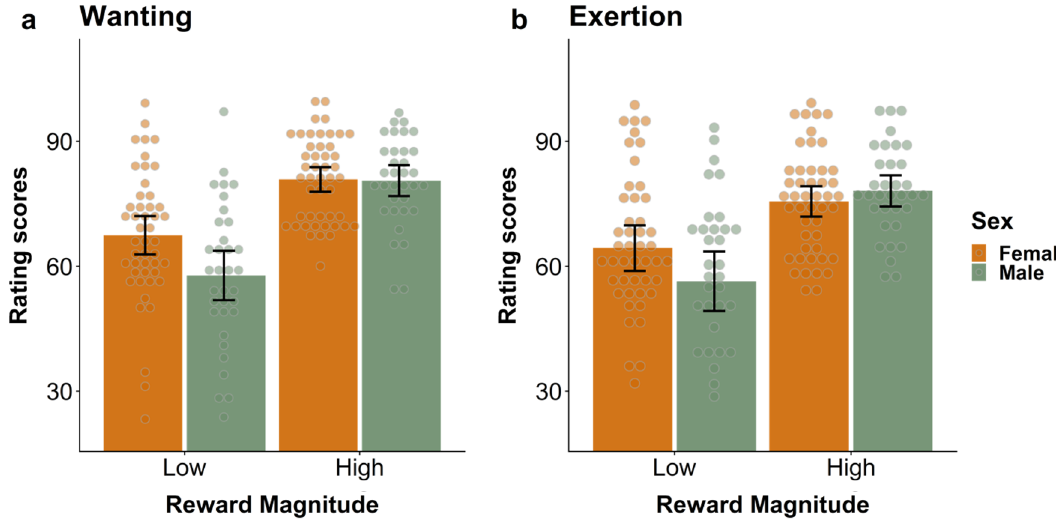
Figure 2. Women and men differed in subjective ratings of wanting and exertion. ( a ) Both women and men had higher wanting ratings for higher rewards than smaller rewards, p < 0.001, but women wanted smaller rewards more than men did, p = 0.003. ( b ) Both women and men reported to put in more effort for higher rewards than for smaller rewards, p < 0.001, and women reported more exertion for smaller rewards than men, p =